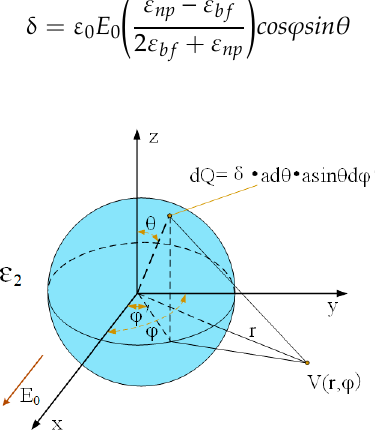
Figure 5. Surface polarization of charged nanoparticles in a continuous dielectric field.